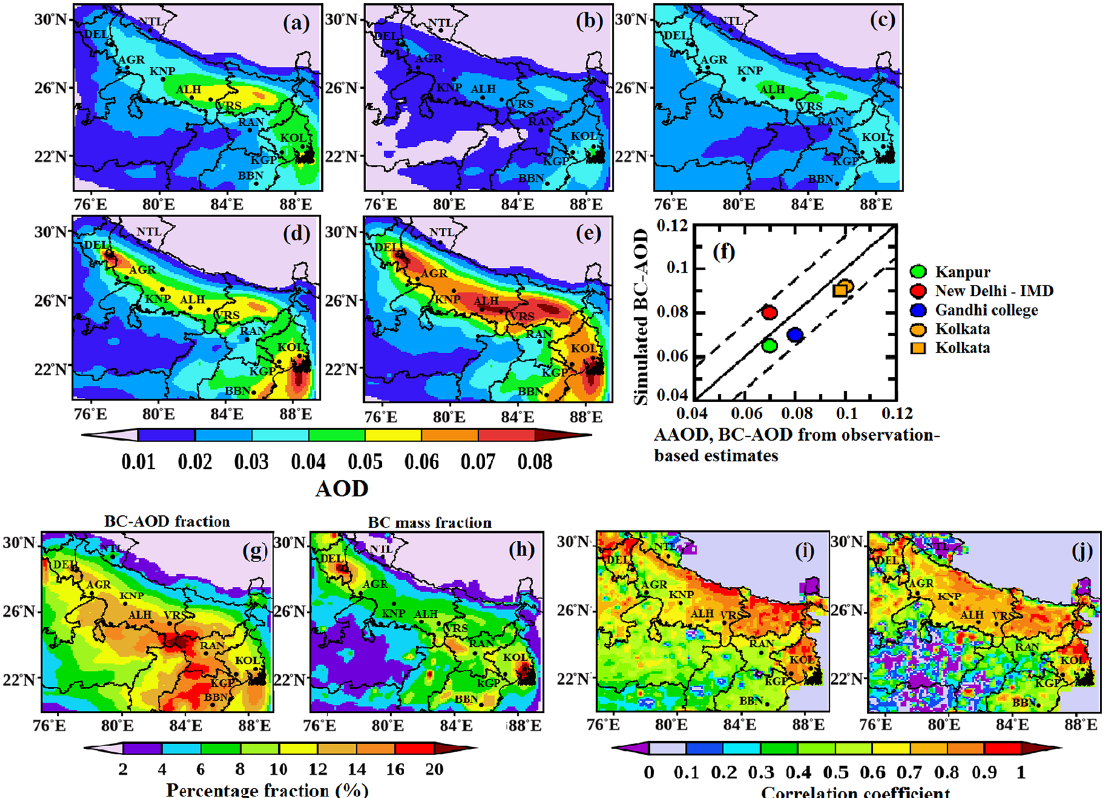
Figure 5. (a–e) Spatial distribution of simulated winter monthly mean BC-AOD at 550nm over the IGP from the simulations (a) Smog, (b) Edgar, (c) Cmip, (d) Pku, and (e) Constrained. (f) Comparison of simulated BC-AOD from the Constrained simulation with the AAOD represented as circles (from AERONET-based observations at stations at Kanpur, New Delhi IMD, Gandhi College, and the IIT Kharagpur extension at Kolkata) and with BC-AOD represented as a square estimated using in situ ground-based observations at Kolkata; the dashed lines correspond to the value within ± 25% of the 1:1 comparison shown as a solid line. (g–h) Spatial distribution of the (g) BC-AOD fraction (%) and (h) BC mass fraction (%) from the Constrained simulation. (i–j) Correlation between the variance in the BC emission flux from five BC emission databases and in estimated (i) BC-AOD and (j) BC concentration from five